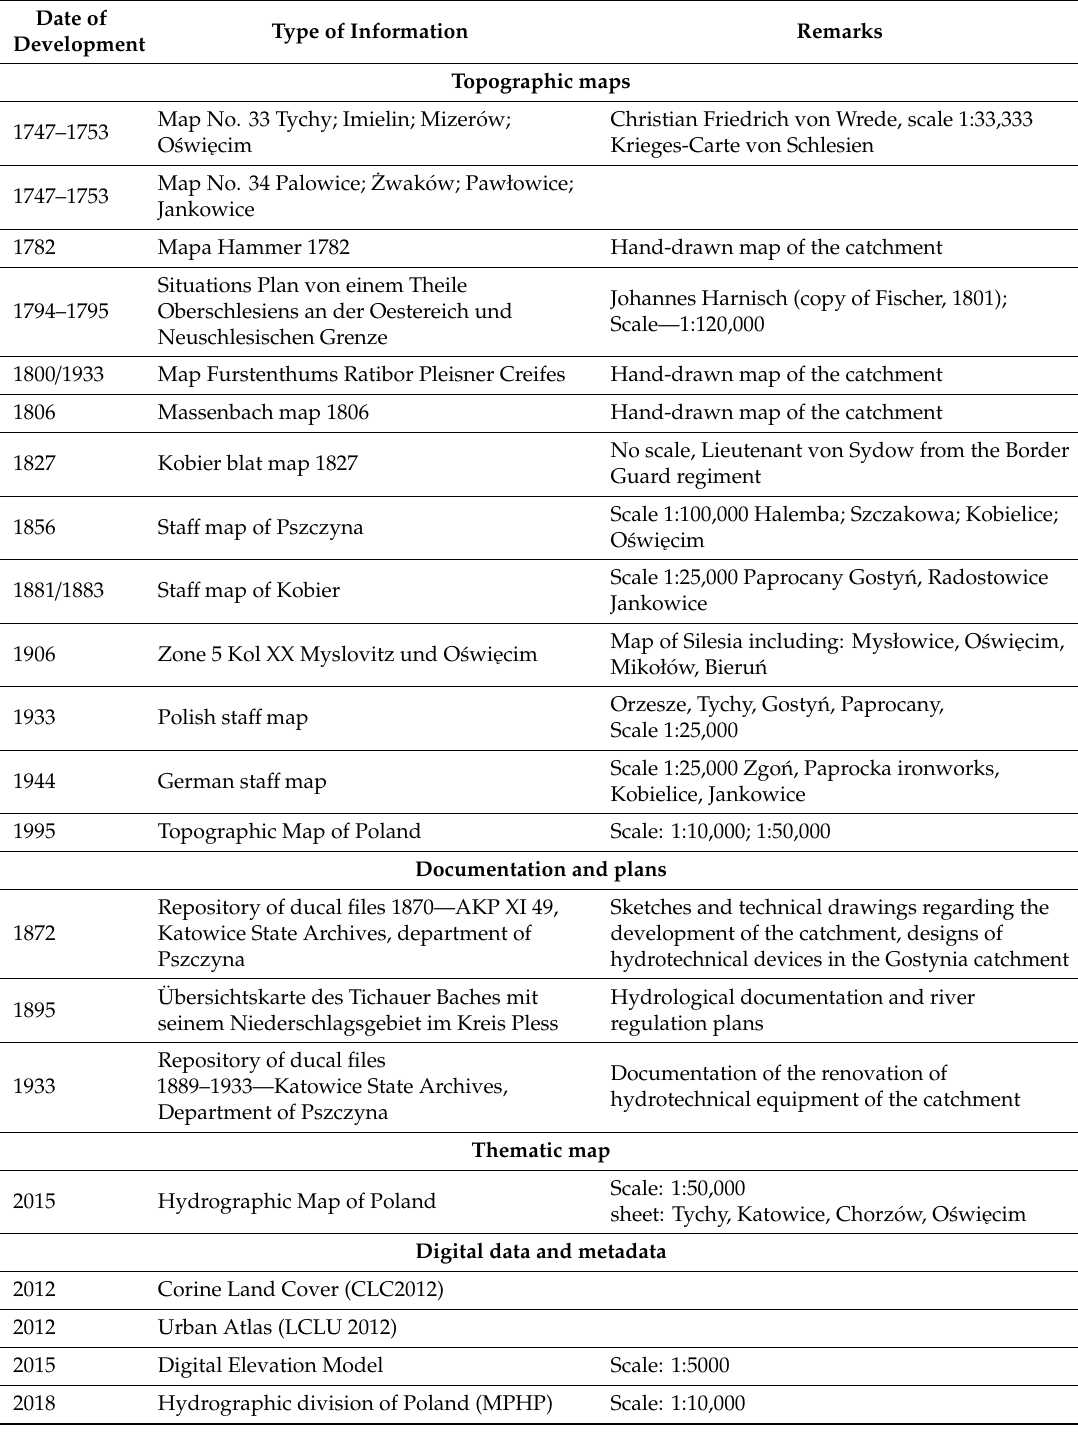
Table 1. Cartographic data sources—historical and contemporary maps and digital